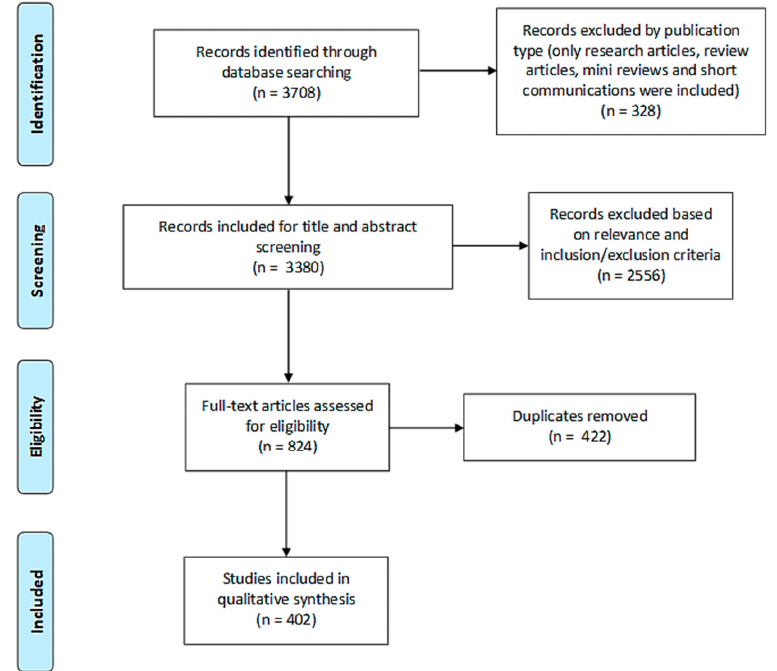
Figure 1. PRISMA flow diagram of study search and selection process of Section 1 . Molecules 2020 , 25 , x FOR PEER REVIEW